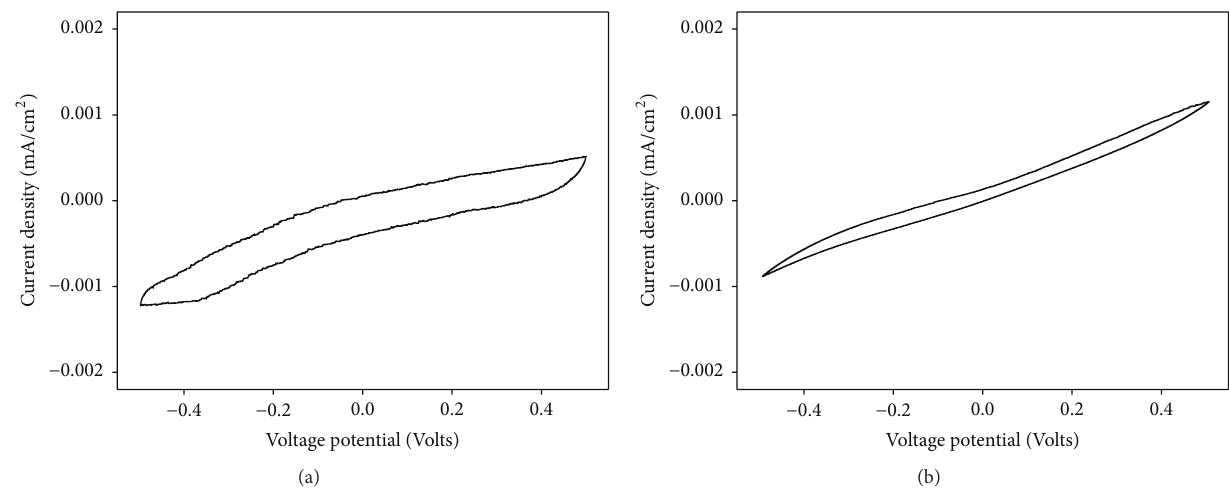
Figure 9: Cyclic voltammetric curves: (a) [MG49-25.0 wt.% LiClO 4 ]:[8.0 wt.% HNO 3 -THF/TiO 2 -SiO 2 ] and (b) [MG49-25.0 wt.% LiClO 4 ]:[8.0 wt.% ClHNO 2 -THF/TiO 2 -SiO 2 ] polymer